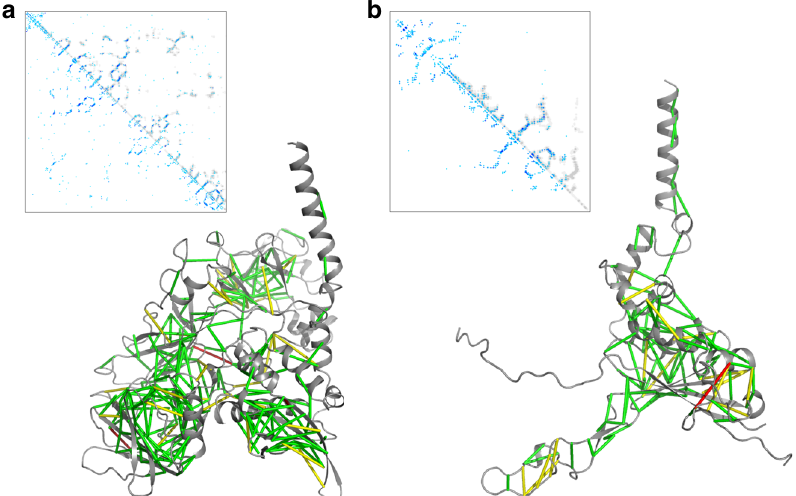
Fig. 4 Co-evolution-predicted distance constraints for TssF and for TssG. a , b Ribbon diagrams of TssF a and TssG b showing coevolving pairs of residues with lines colored according to the distance between coevolving residues: green, C α < 6 Å; yellow, C α < 10 Å; red, C α > 10 Å. The insets show contact maps from the models (light gray dots) and those predicted from co-evolution data (blue dots). The gray dots are residue contacts from 5 A (dark gray) to 10 A (light gray). The blue dots are predicted contacts, with the darker and larger dots indicating higher con fi